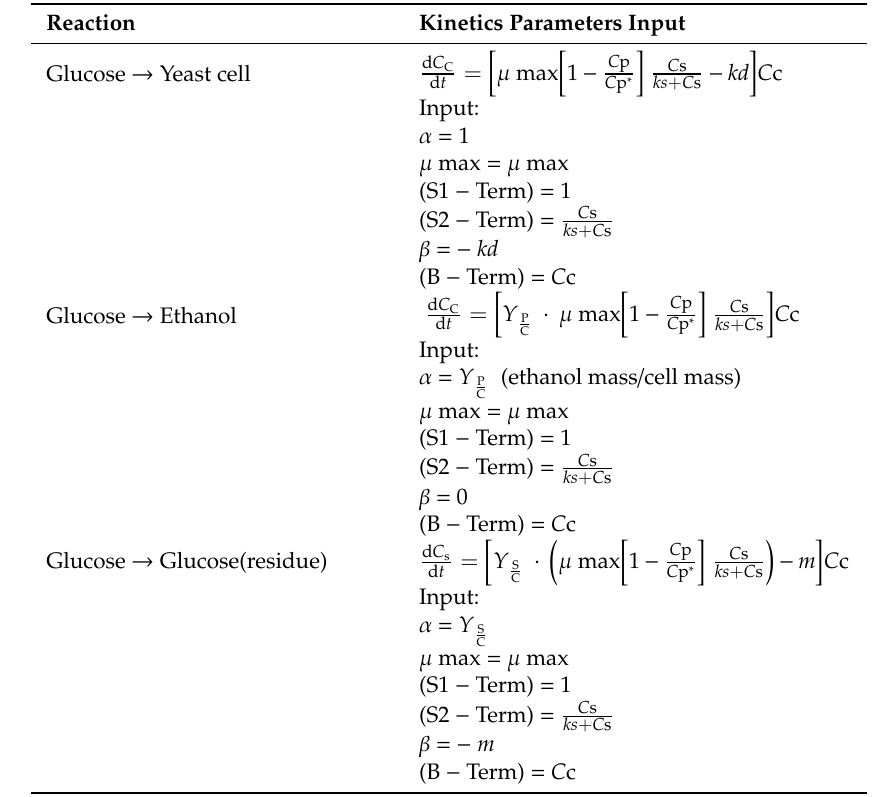
Table 1. Kinetics parameters data used as inputs in SuperPro Designer ®